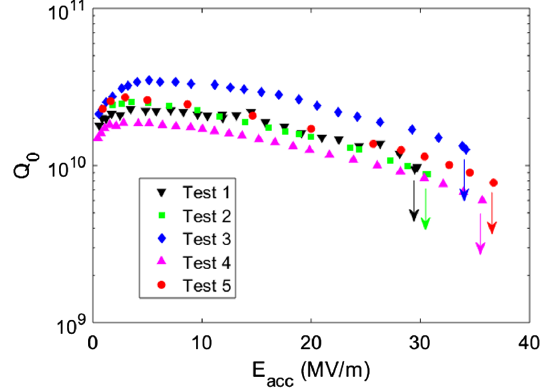
FIG. 2. Q 0 =E curves of the tested single-cell cavities. acc Vertical arrows show quench appearance.